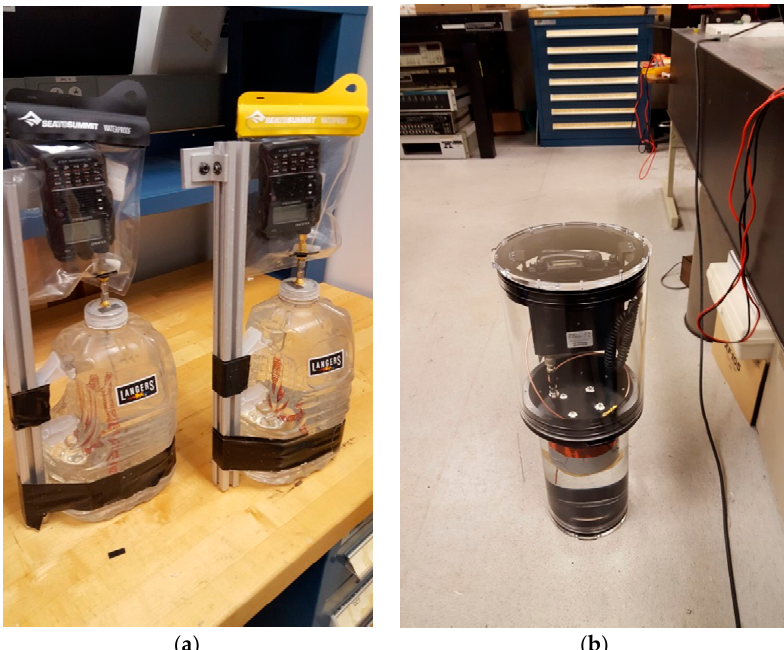
Figure 2. ( a ) SEW underwater antennas attached to Yaesu VX-8 radios operated at 50 MHz. The impedance-matching enclosures are filled with de-ionized water; ( b ) Assembled surface wave underwater antenna operating in the 2 MHz band attached to a Yaesu FT-857 radio operated at 5 W output power. The impedance-matching enclosure (seen in the bottom section of the assembly) is filled with de-ionized water.